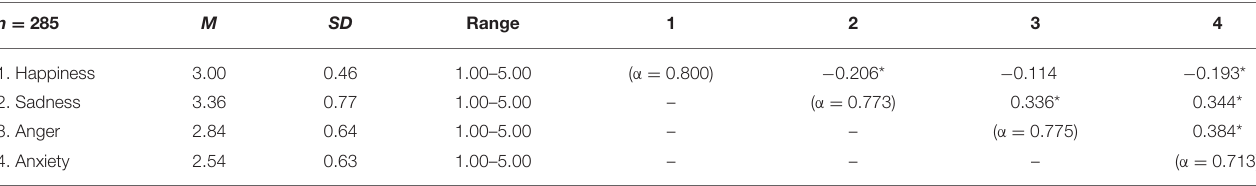
TABLE 2 | Descriptive statistics and internal consistency of and correlations between the four subscales of the Salzburg Emotional Eating Scale in study